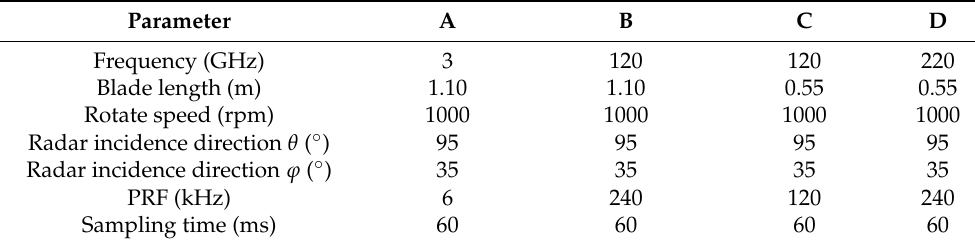
Figure 6. The three-bladed turbine model. Table 1. Table of simulation parameters of the three-bladed turbine in different frequency